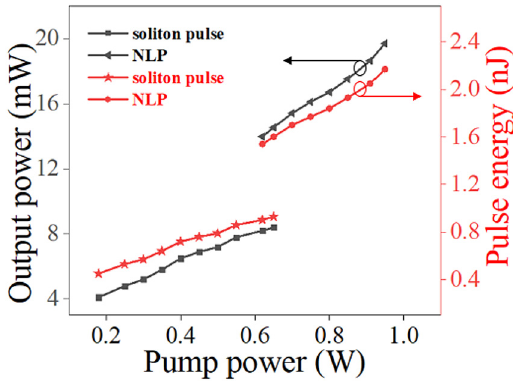
Figure 9: The average output power and single pulse energy of soliton pulse and NLP against pump